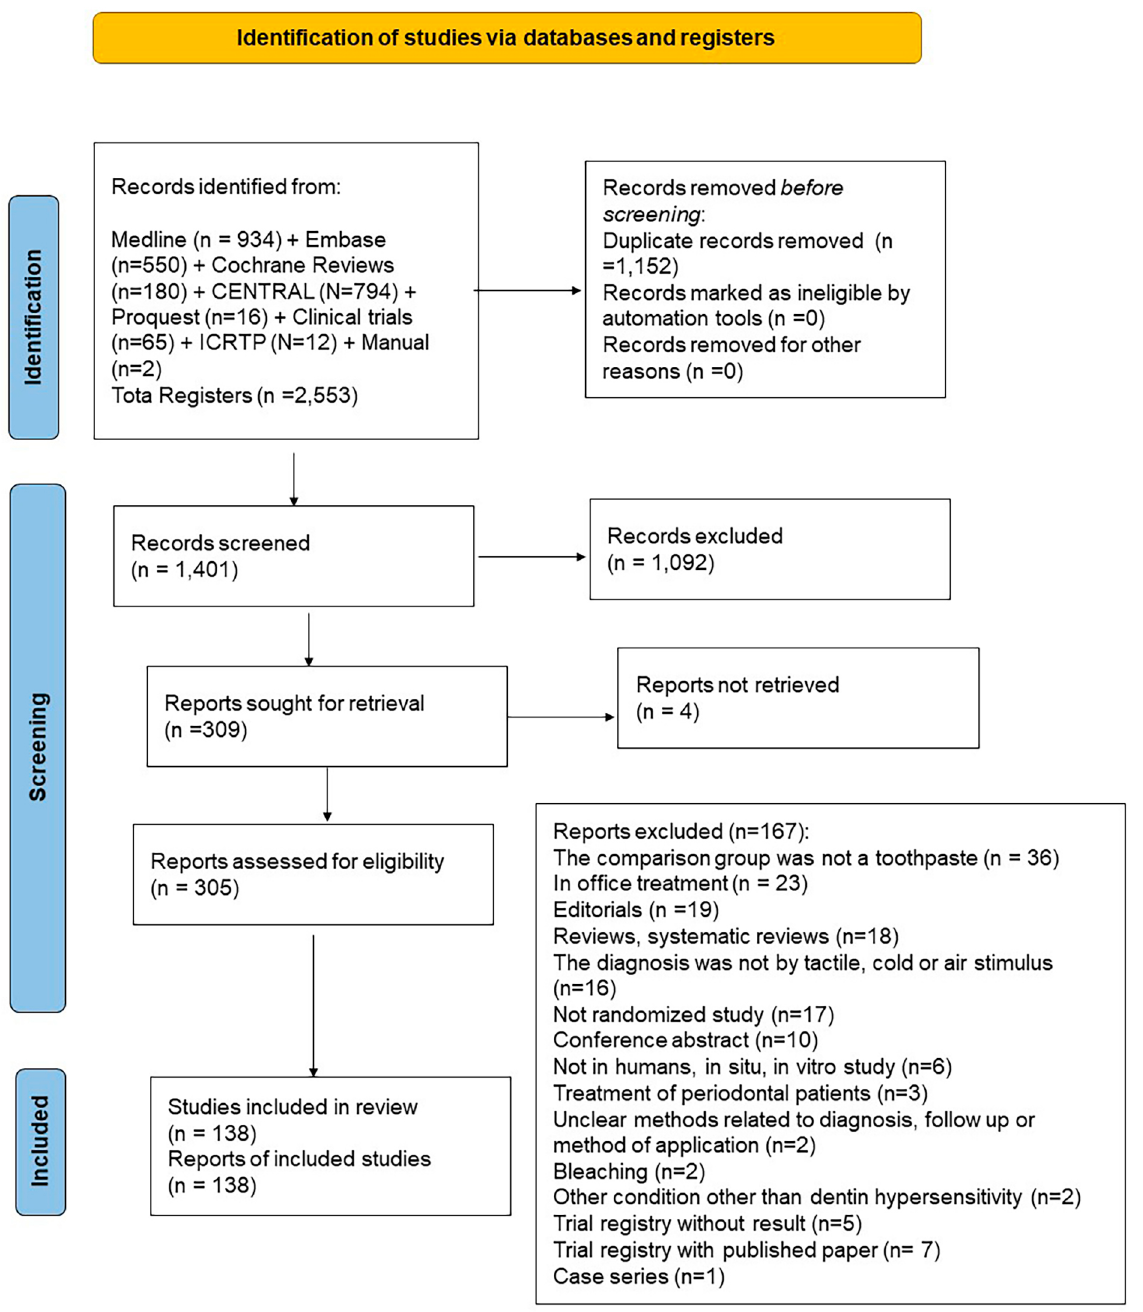
Figure 1- PRISMA 2020 flow diagram showing our screening